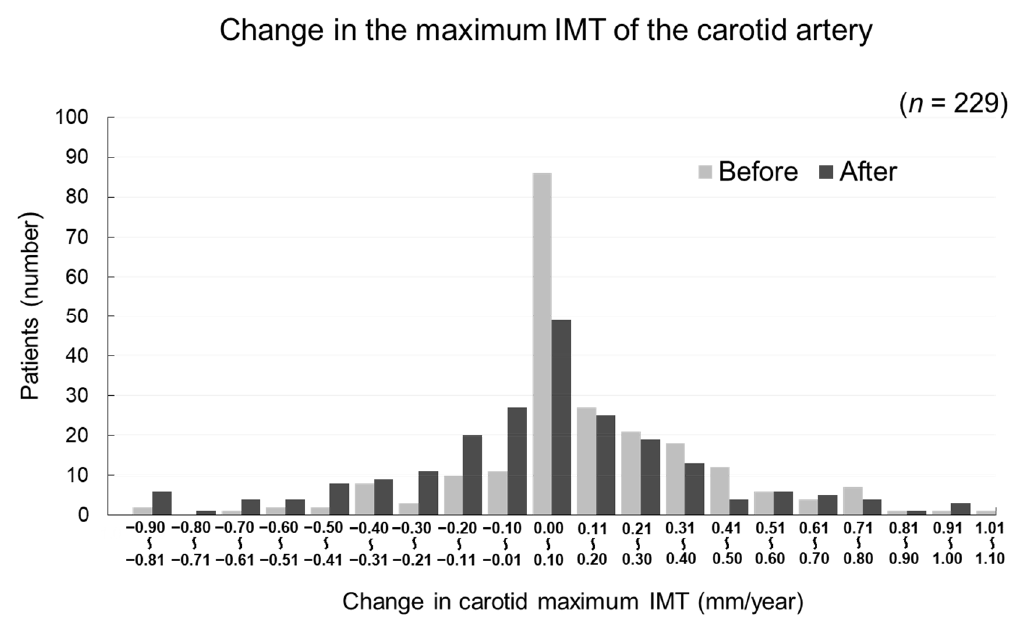
Figure 6. Distribution of participants according to the change in carotid maximum IMT during the 12 months before and after the administration of evolocumab.